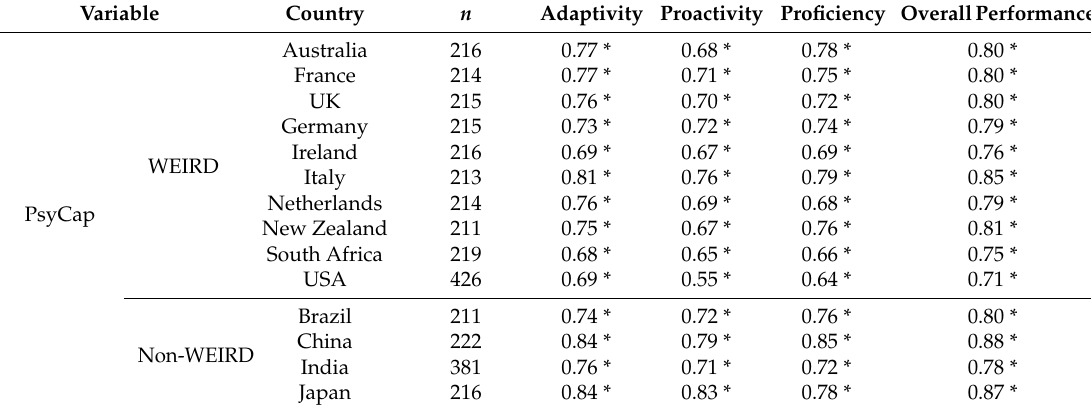
Table 2. Zero order correlations between PsyCap and job